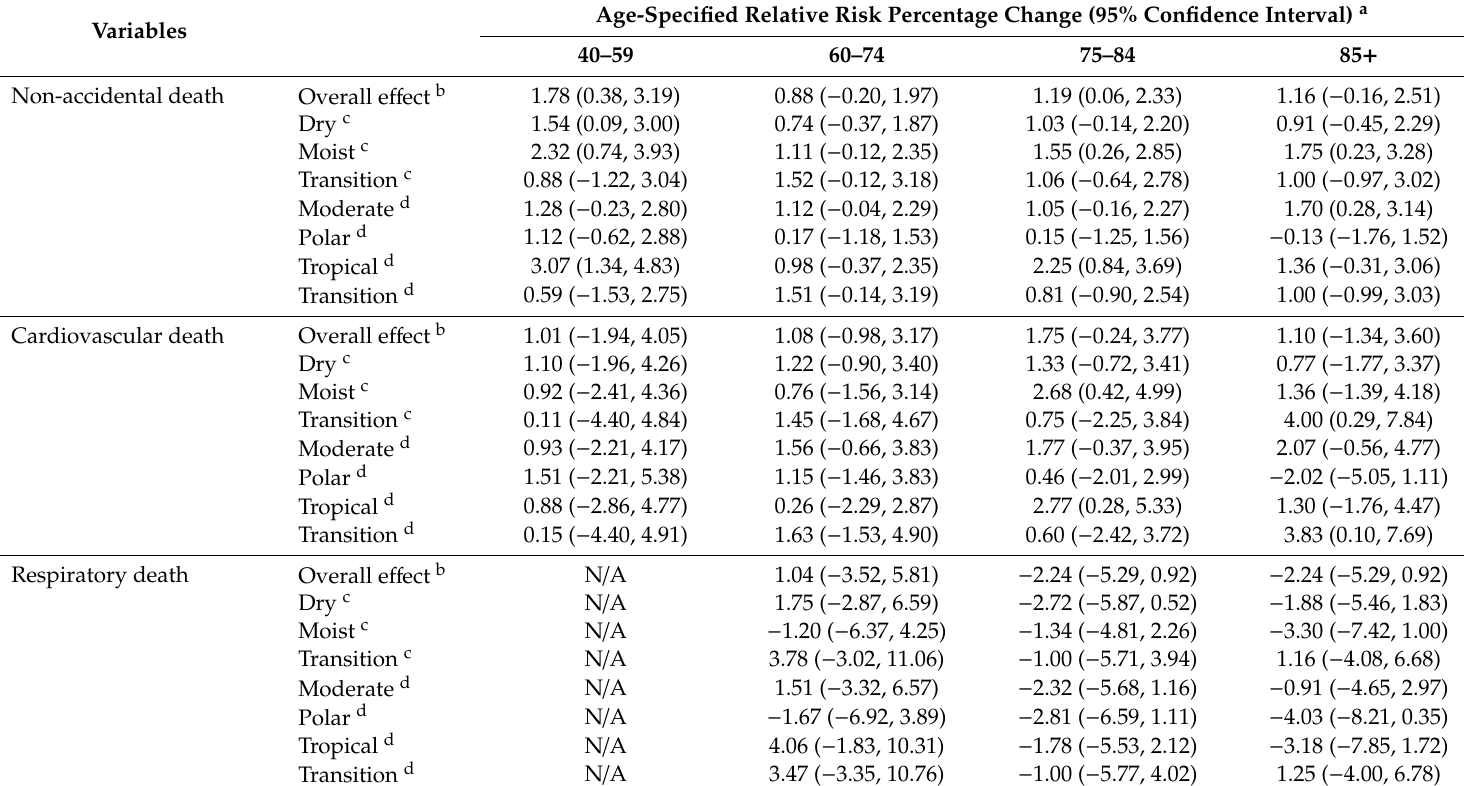
Table 3. Age-specified relative risk percentage change between daily mortality and PM 10 concentration according to SSC types in Seoul, South